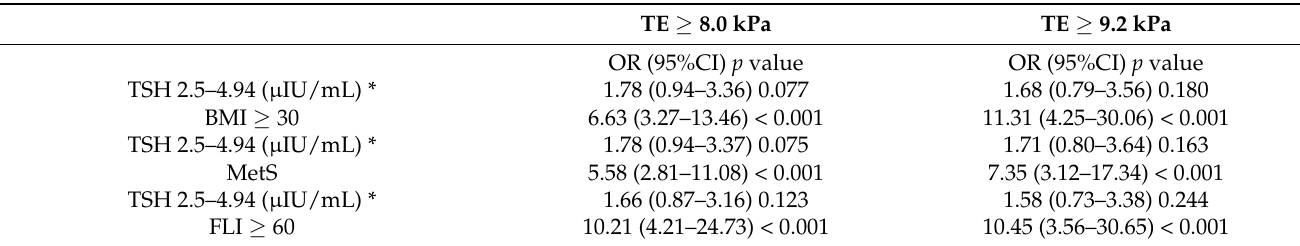
Table 6. Multivariate analysis of risk of liver fibrosis using different transient elastography cut-offs as dependent variables in low-normal thyroid function (TSH 2.5–4.94 µ IU/mL) vs. strict-normal thyroid function (TSH < 2.5 µ IU/mL). Three different multivariate logistic regression models adjusted for BMI, MetS and